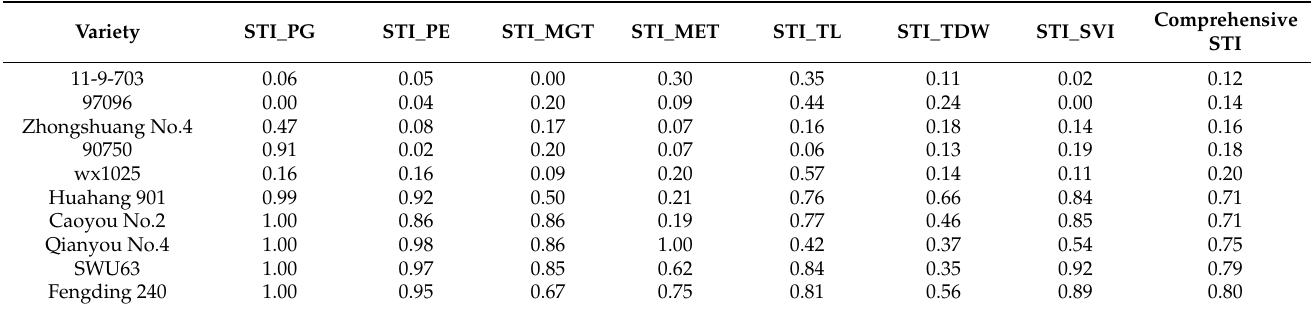
Figure 4. Comprehensive low-temperature stress tolerance index frequency distribution ( A ) and Shapiro–Wilk normality test outcome ( B ). Table 3. Screening results of low-temperature-tolerant and -sensitive genotypes based on comprehen- sive STIs from membership function. STI_PG, low-temperature stress tolerance index of germination percentage; STI_PE, low-temperature stress tolerance index of emergence percentage; STI_MGT, low-temperature stress tolerance index of mean germination time; STI_MET, low-temperature stress tolerance index of mean emergence time; STI_TDW, low-temperature stress tolerance index of to- tal dry weight; STI_TL, low-temperature stress tolerance index of total seedling length; STI_SVI, low-temperature stress tolerance index of seedling vigor